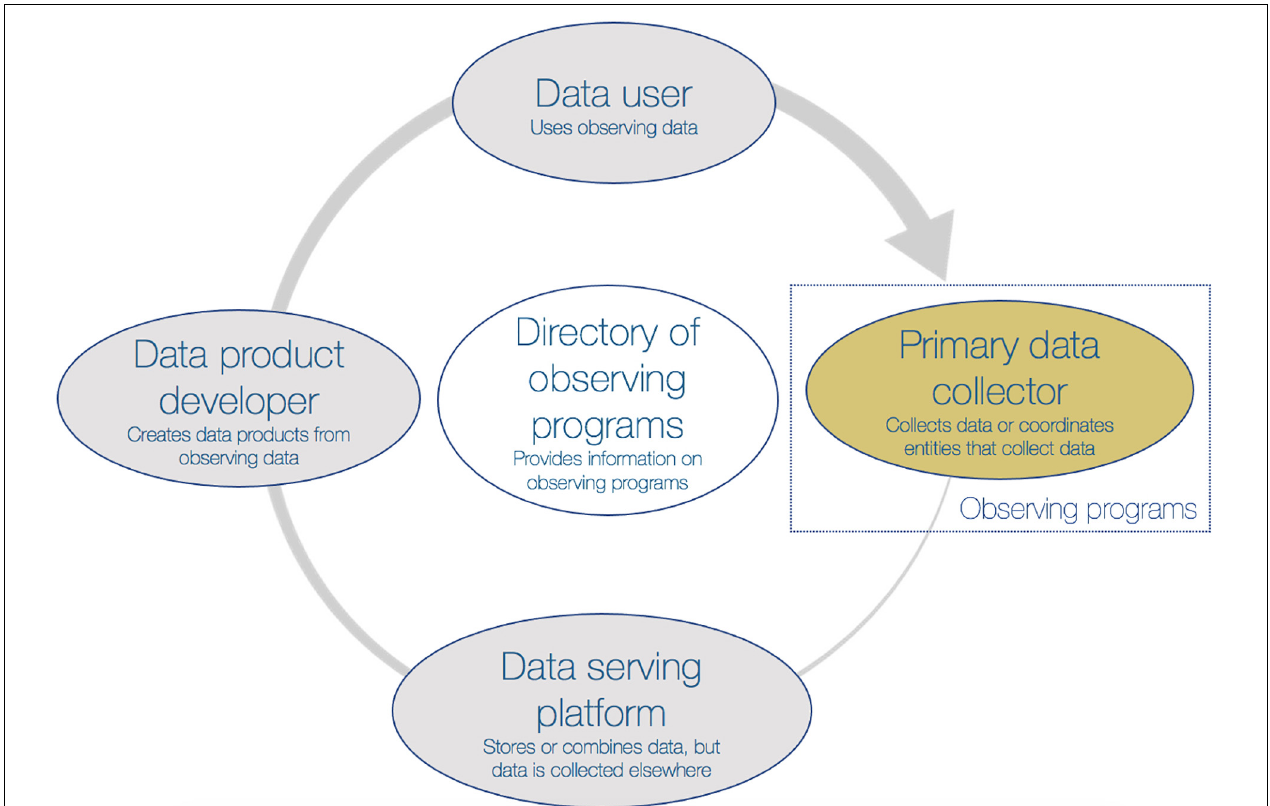
FIGURE 1 | Types of observing entities within the context of the idealized ocean observing data lifecycle. Primary data collectors (yellow oval) can be individual programs or networks of data collectors (referred to as observing programs in this study). The data collected then feed into data serving platforms, such as repositories or aggregators, where they can be accessed by data product developers and then used by data users. Ideally, the data users then help guide refinement of the choice and methods of data collected to answer relevant scientific and societal questions to ensure a “fit for purpose” observing system. A directory of observing programs can provide essential information related to the observing entities in order to understand the key actors involved in the ocean observing data lifecycle. Definitions for each type of observing entity are provided below each category in the figure and are included in Supplementary Material 2 (Question 14). The thickness of the gray arrow indicates the value of the data, which increases as data are shared and used. The results of this study focus on the primary data collectors (observing programs; yellow oval in the dotted blue box) which could directly contribute data to a global ocean observing